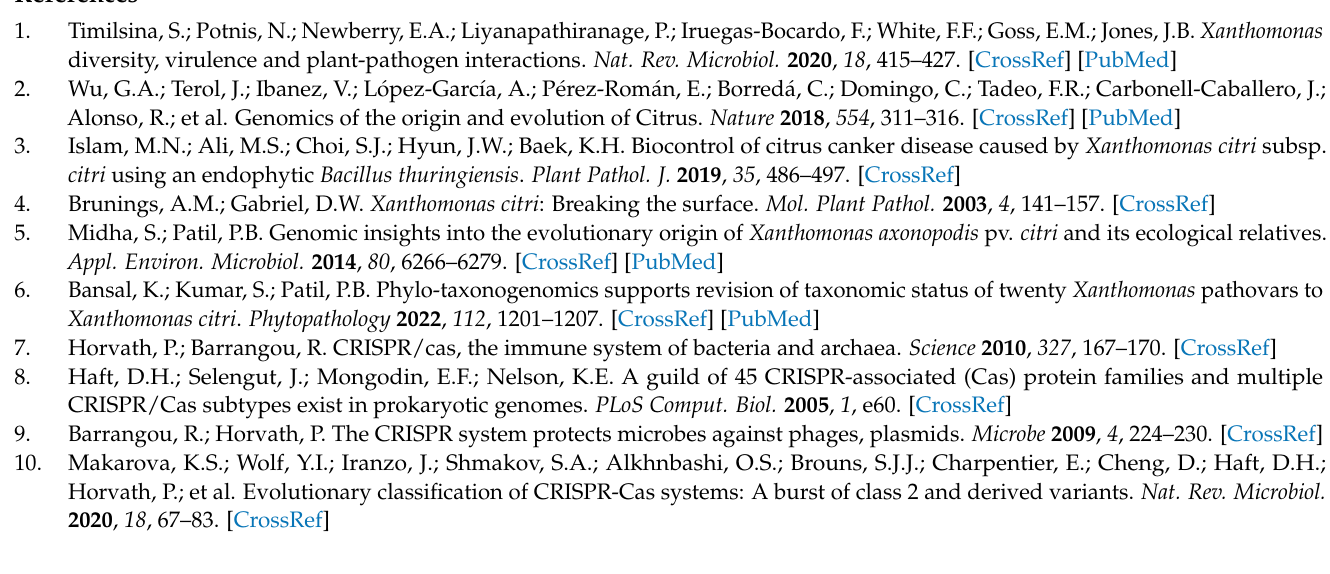
herbarium specimen; Table S1: Genomic resources; Table S2: Inventory of X. citri CRISPR spacers; Table S3: Spoligotypes of X. citri pv. citri CRISPR